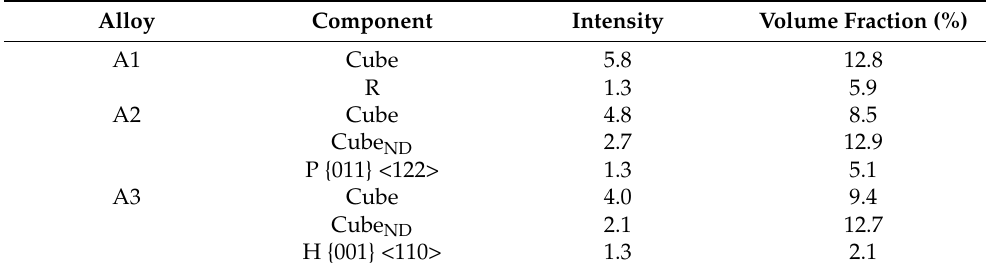
Figure 6. The ODF maps showing recrystallization texture of A1, A2, and A3 alloys after solution treatment: ( a ) A1 alloy, ( b ) A2 alloy, and ( c ) A3 alloy. Table 1. Intensity and volume fraction of recrystallization texture components of A1, A2, and A3 alloys after solution treatment obtained from the ODF maps.